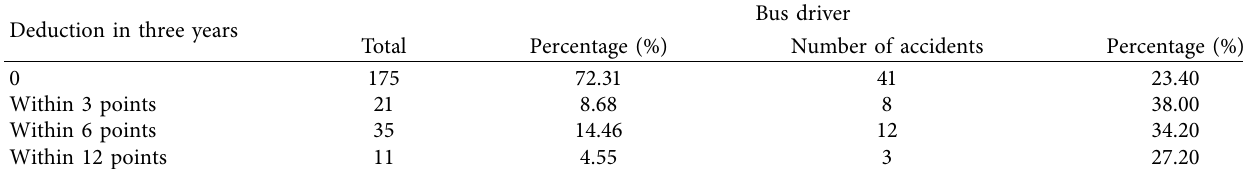
Table 8: Distribution of driving license points deductions in a three-year